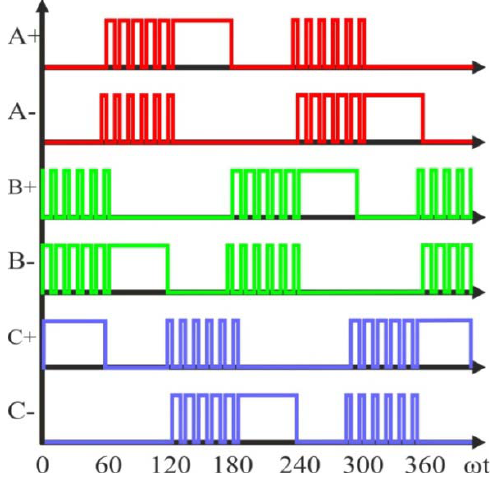
Figure 16. PWM waveform for low power PWM technique, where ωt є [60°,120°] and TA+ is “off”